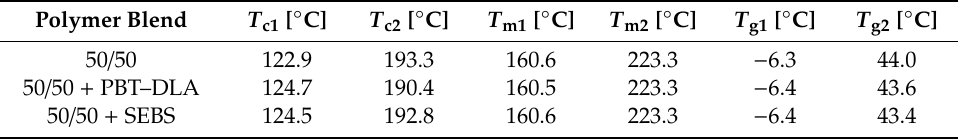
Table 5. Thermal properties of 50 / 50 PP / PBT